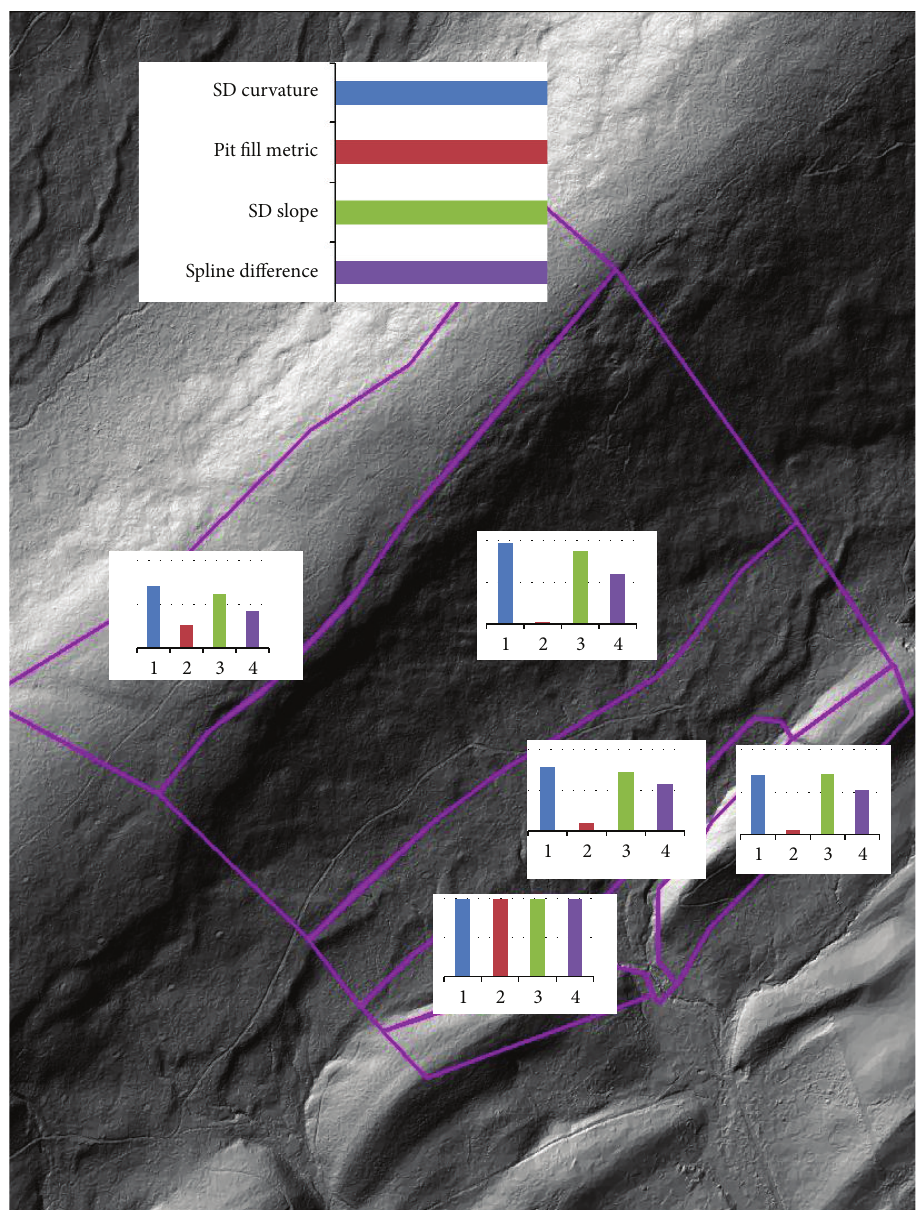
Figure 11: Roughness landforms with bar graphs showing relative value of roughness indices for each